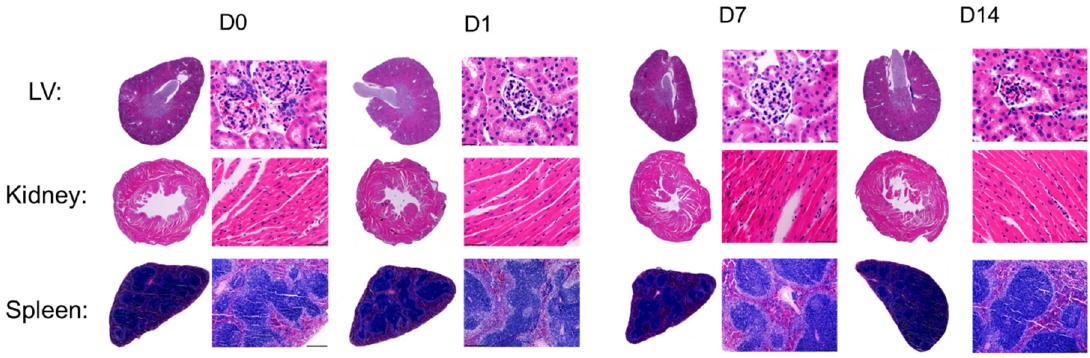
injection with PVCL 10 -PDMS 65 -PVCL 10 polymersomes at D0 (control), D1, D7, and